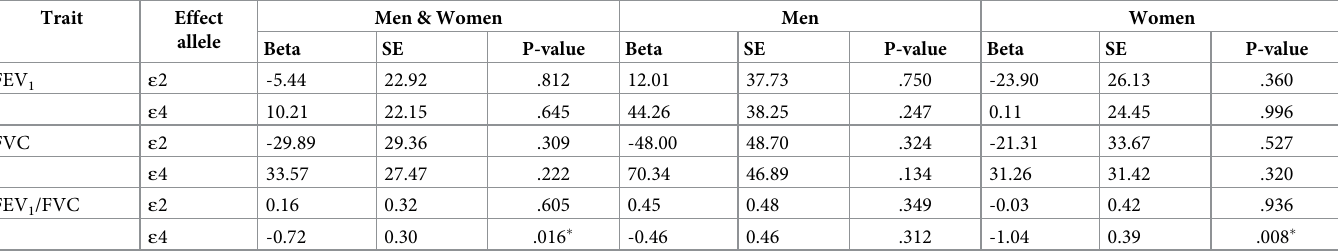
Table 3. Associations of the APOE ε 2 and ε 4 alleles with FEV 1 , FVC and FEV 1 /FVC in the sub-group of 3,832 genotyped LLFS participants without lung disease. Trait Effect allele